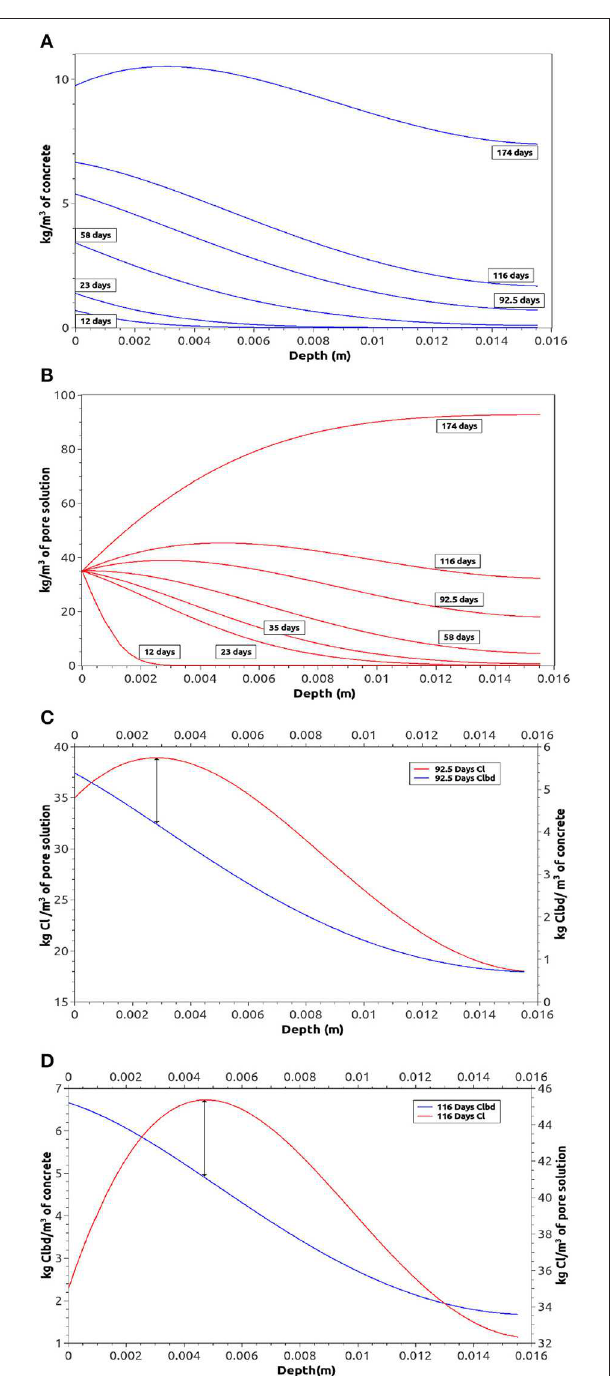
FIGURE 8 | Numerical chloride profiles in thin samples. (A) Bound chloride profiles on time, (B) free Chloride profiles on time, (C) bound and free chloride profiles after 92 days, (D) bound and free chloride profiles after 116